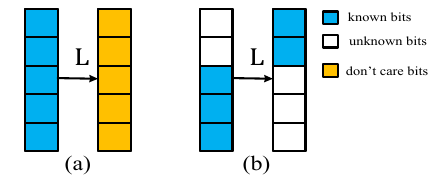
Figure 5: Representatives when the sum state is